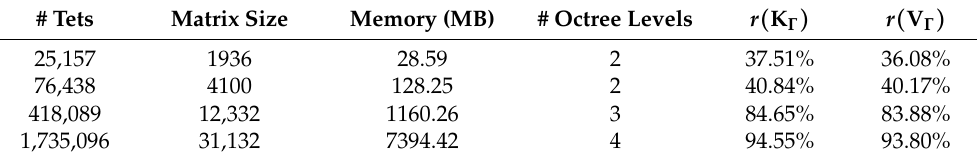
Table 4. Compression ratio of single-layer matrix K Γ and double-layer matrix V Γ with R-SVD. # Tets Matrix Size Memory (MB) # Octree